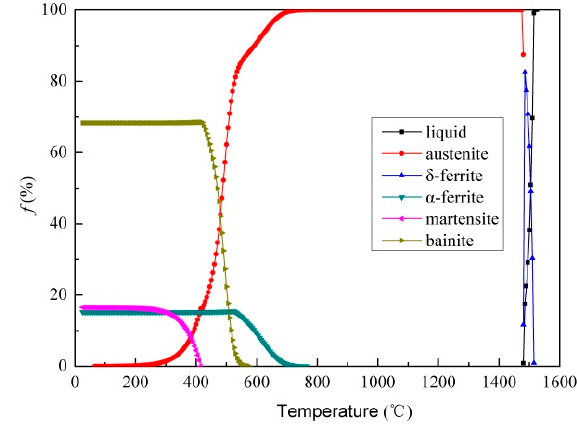
Figure 2. Phase transformation with temperature of microalloyed steel calculated by Jmatpro.